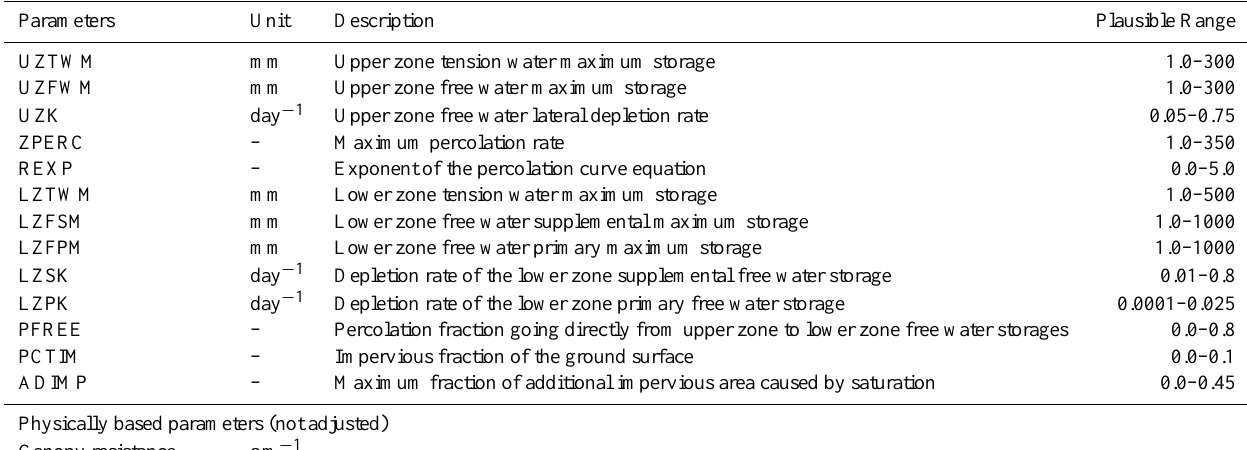
Table 2. List of ULM soil parameters from Sac and their plausible